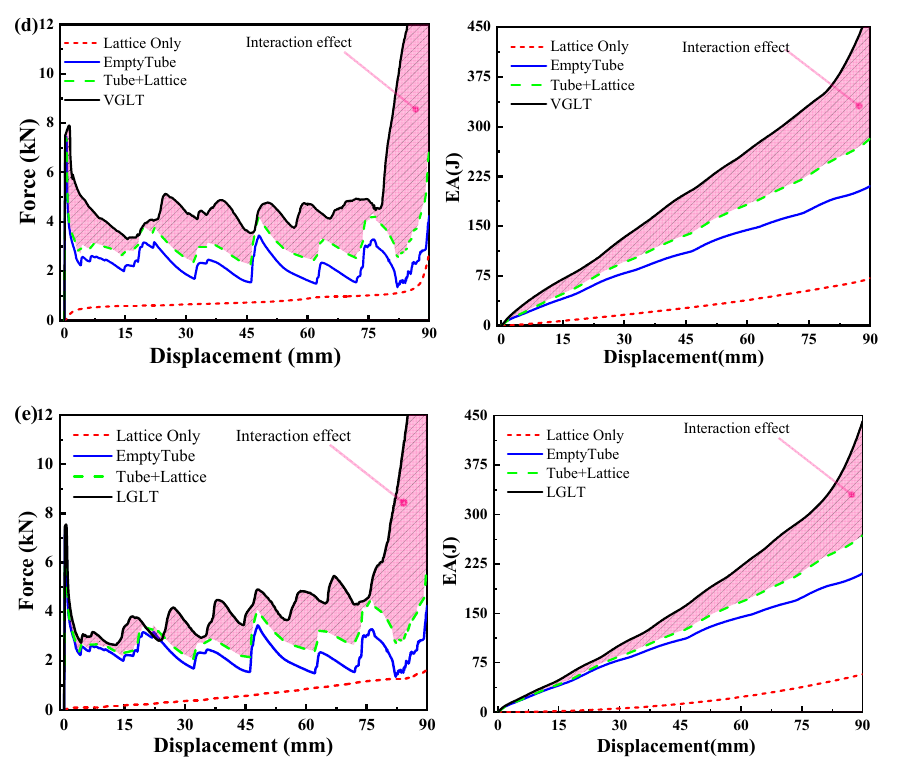
Figure 13. Force–displacement curves and energy absorption of each component of the hybrid struc‑ ture: ( a ) ULT1, ( b ) ULT2, ( c ) ULT3, ( d ) VGLT, ( e ) LGLT.